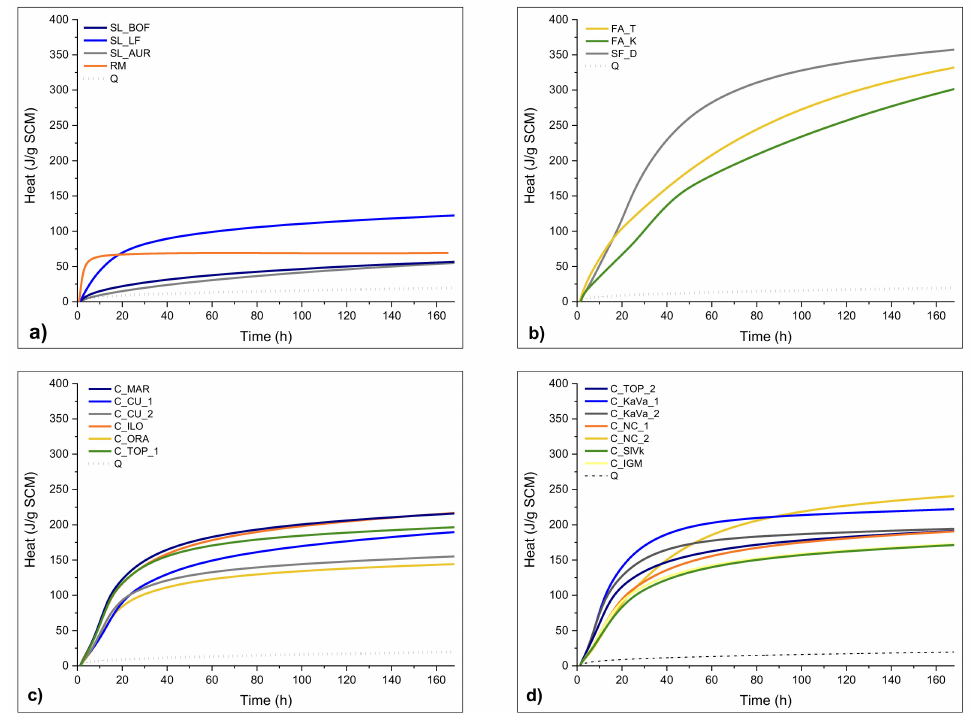
Figure 7. Heat of hydration obtained by R3 test using calorimetry during seven days: ( a ) slags, iron silicate fines and red mud ( b ) silica fume, limestone and fly ashes, ( c , d )